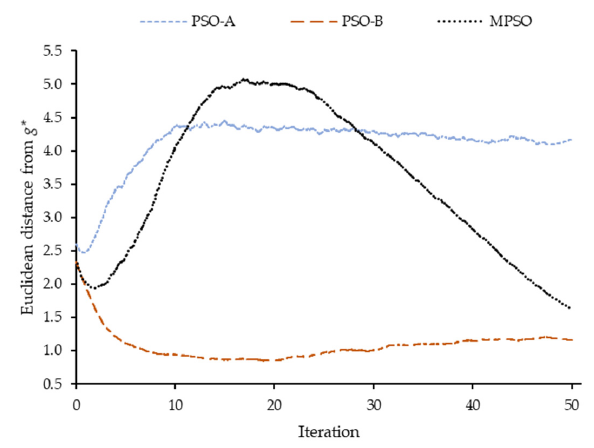
Figure 7. Influence of modification in the pathway of particles.